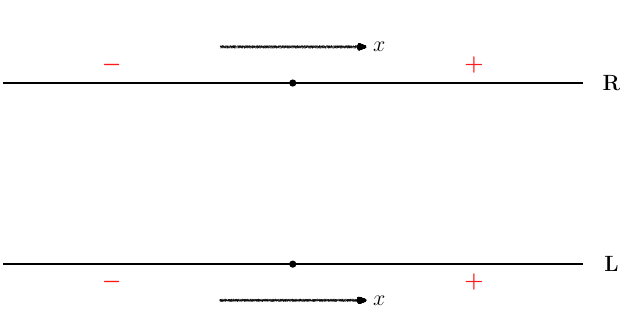
Figure 3 . We draw ICFT black hole. Each ICFT consists of three components of CFT (cid:0) conformal symmetries of SO(1 ;